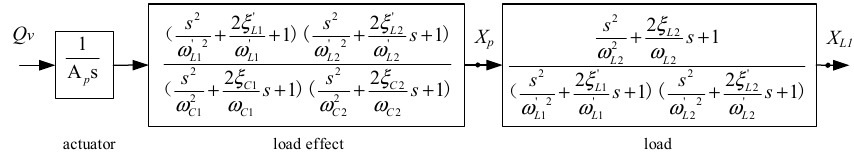
Figure 8. The control block diagram of actuator-engine system. With minor loops eliminated and some algebraic transformations, the condensed actuator-engine diagram is represented in Figure 9, with the two measurement points X p and X L 1 remained.